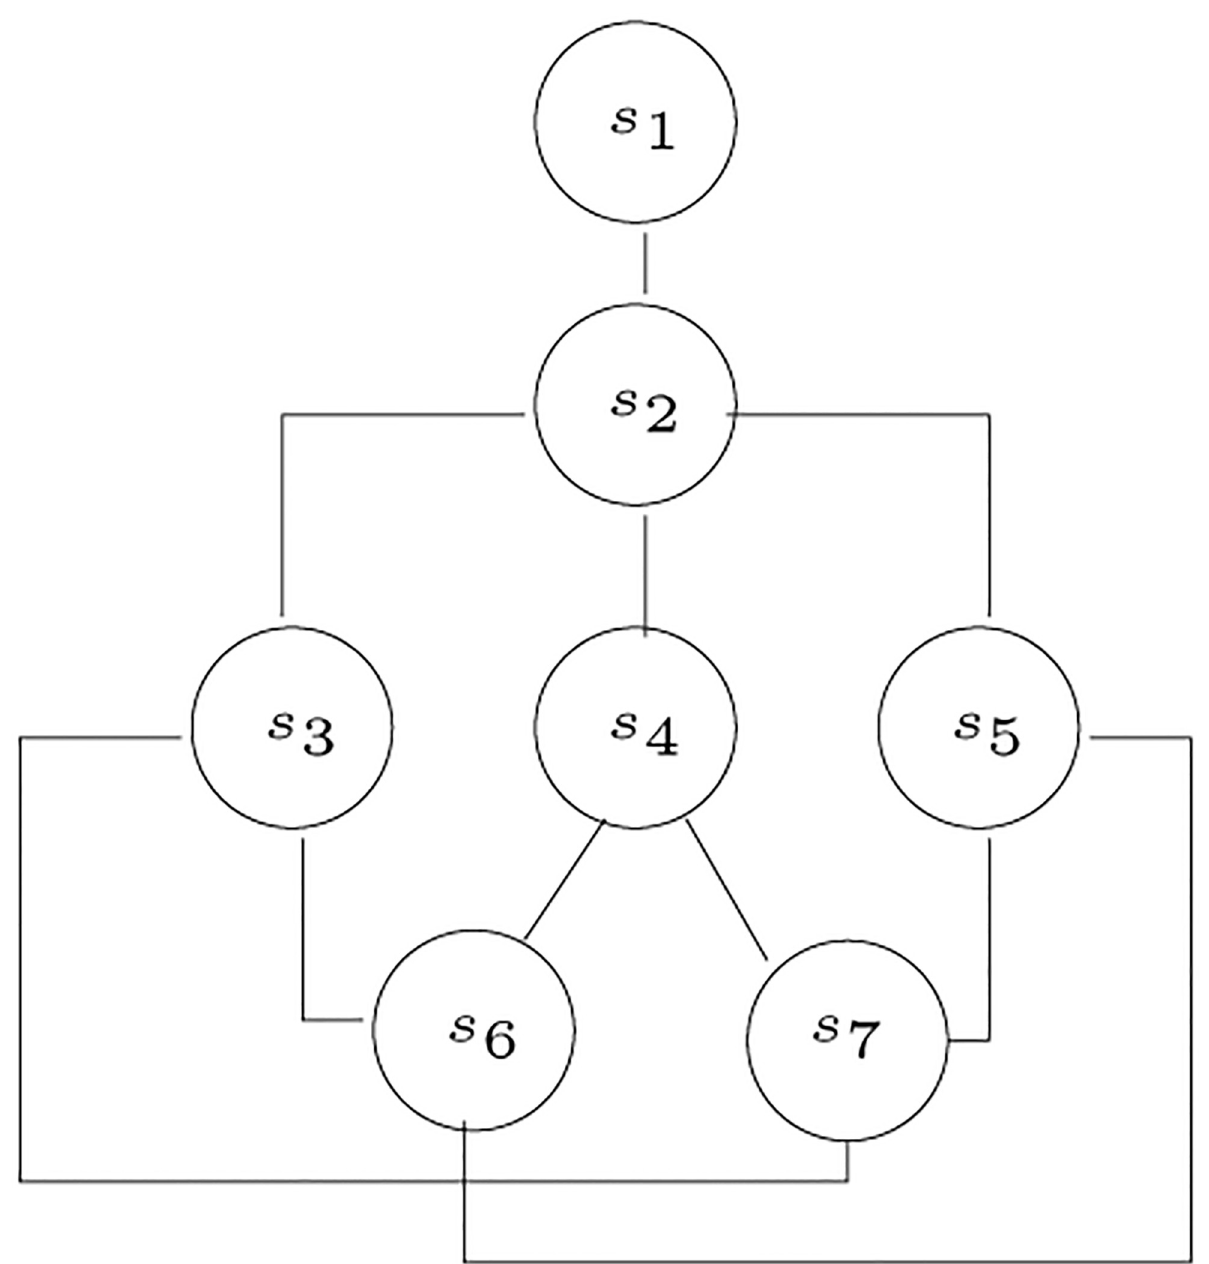
Fig 5. An example of a Hasse